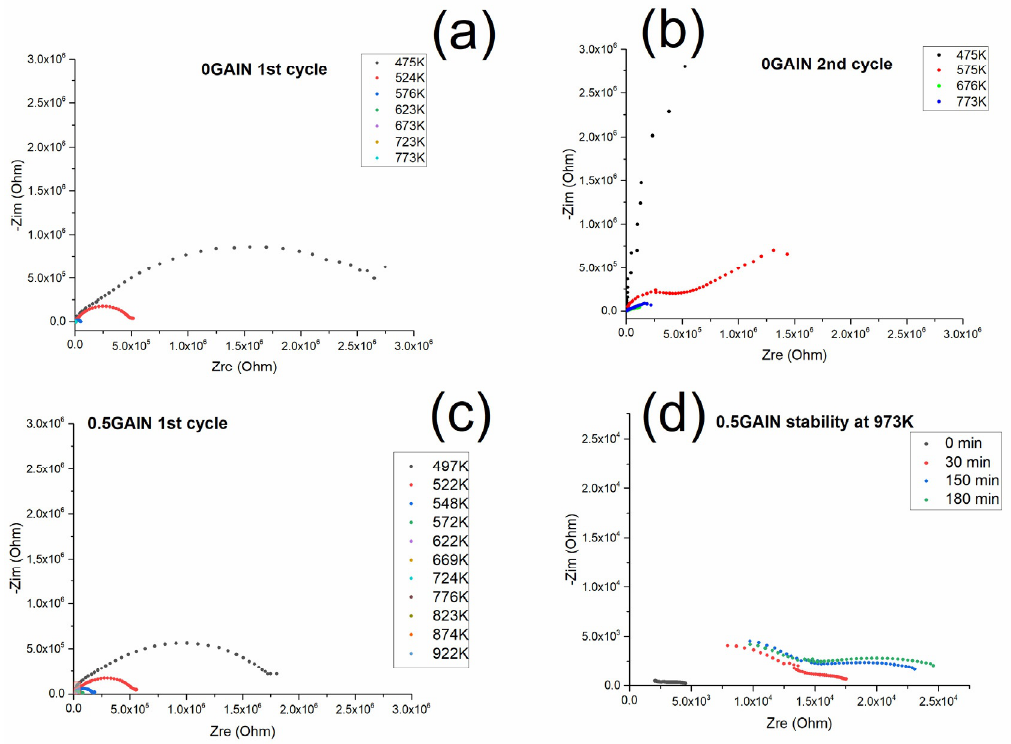
Figure 12. Electrochemical studies of ( a ) impedance spectra during the first cycle of heating/cooling for 0 GAlN; ( b ) impedance spectra during second cycle of heating/cooling for 0 GAlN ( c ) impedance spectra during the first cycle of heating/cooling for 0.5 GAlN; ( d ) impedance spectra at 973 K for 0.5 GAlN.